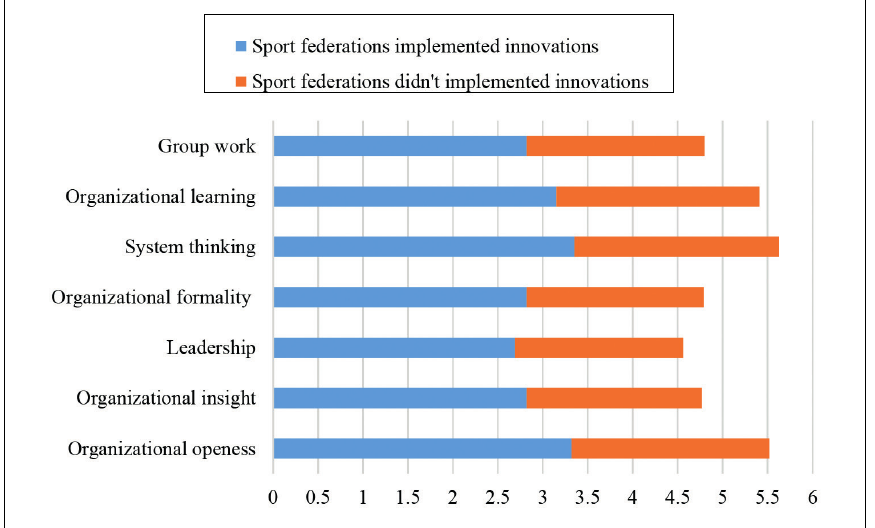
Figure 2. The relationship